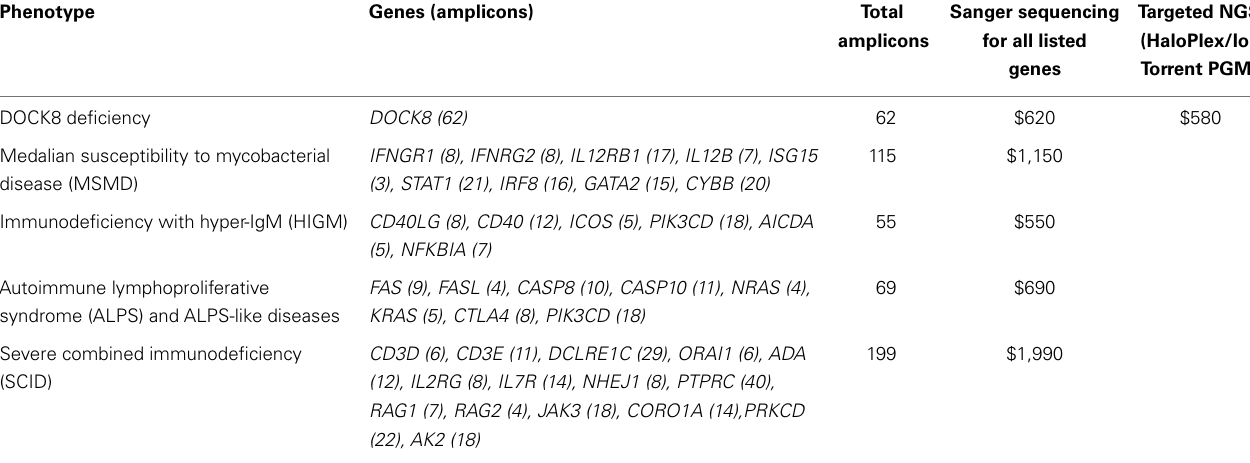
Table 5 | Maximal reagent costs of targeted NGS vs. Sanger sequencing of genes included in the sequence capture design